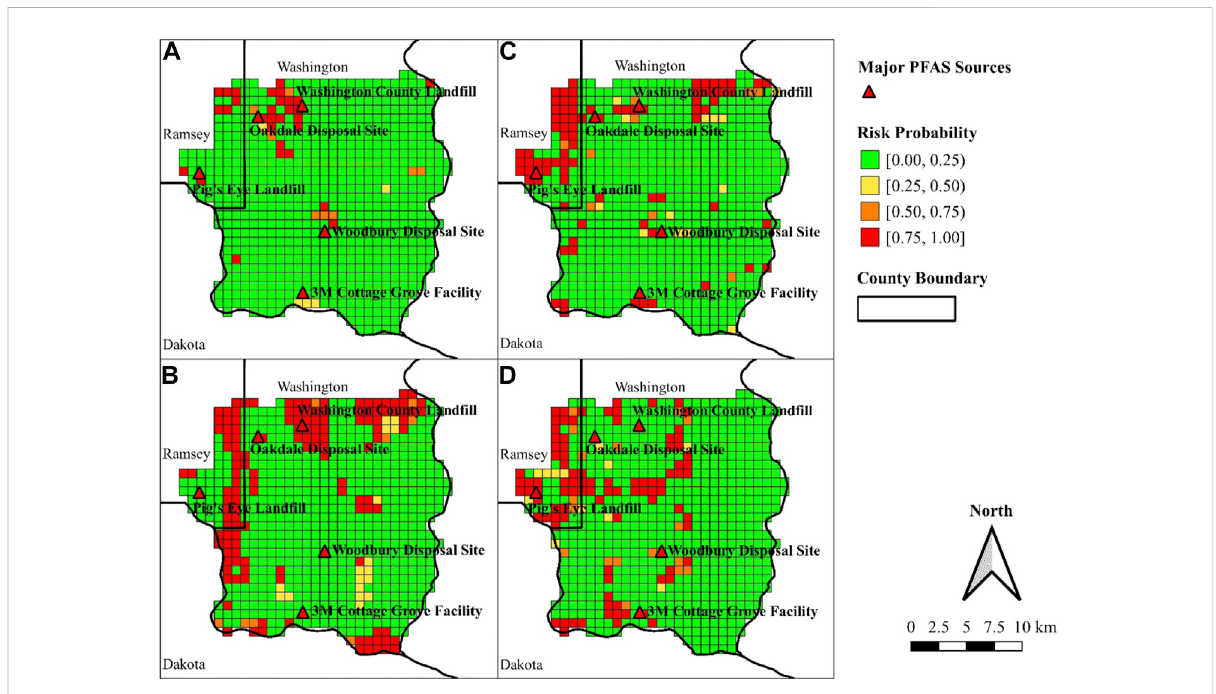
FIGURE 6 Predicted exposure risk maps for (A) PFBA, (B) PFBS, (C) PFHxA, and (D) PFHxS (mean predictions at center of each grid cell from trained Bayesian